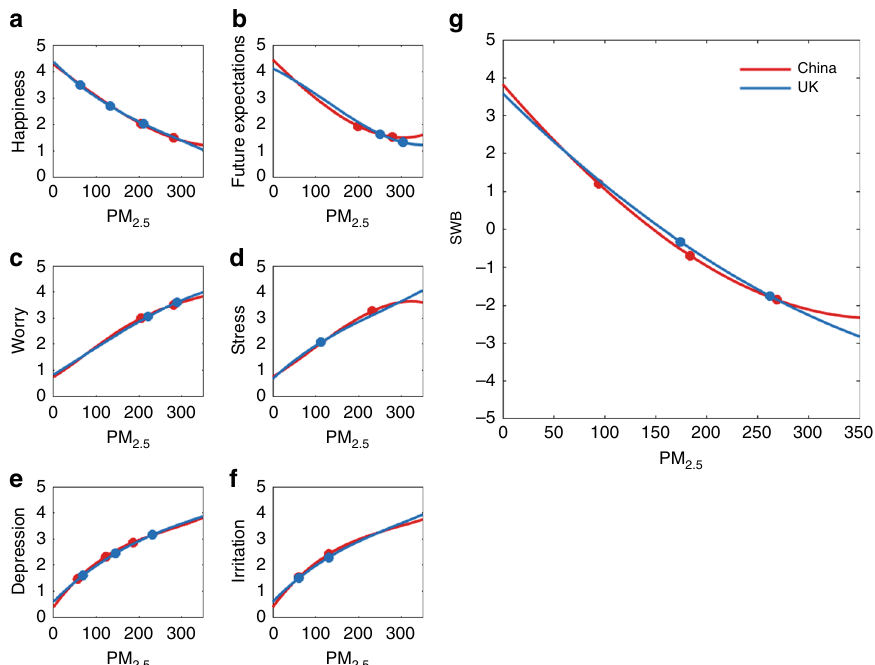
Fig. 3 Polynomial fi tting of air pollutants and perceptual data in country backgrounds. a, b The change in the positive emotions of happiness and future expectations with changes in air pollution. c , d – f The changes in the negative emotions of worry, stress, depression and irritation with changes in air pollution. g The changes in SWB with changes in air pollution. Positive and negative emotions and SWB are compared between observers living in China and the UK. The red line indicates that the observers in China have stronger emotions than those in the UK under the given air pollution condition (PM 2.5 ); the blue line indicates that the observers in the UK have stronger emotions than those in China under the given air pollution condition (PM 2.5